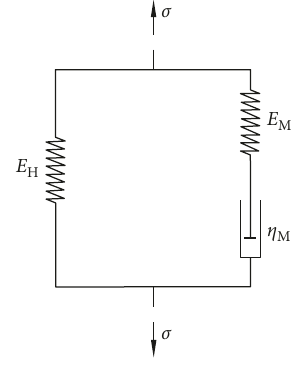
Figure 1: Viscoelastic